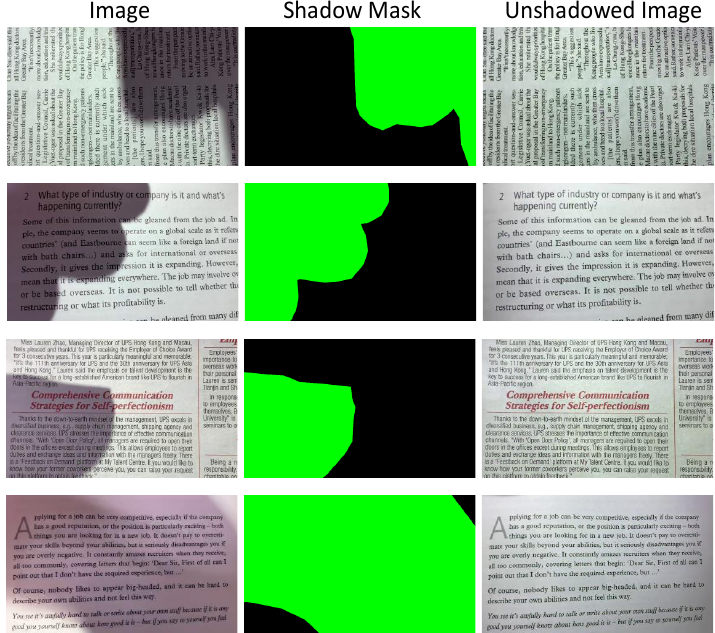
Figure 5. Some examples of the proposed dataset. Specifically, the middle column gives the shadow masks and the green areas indicate the shadow regions. The right column represents the ground